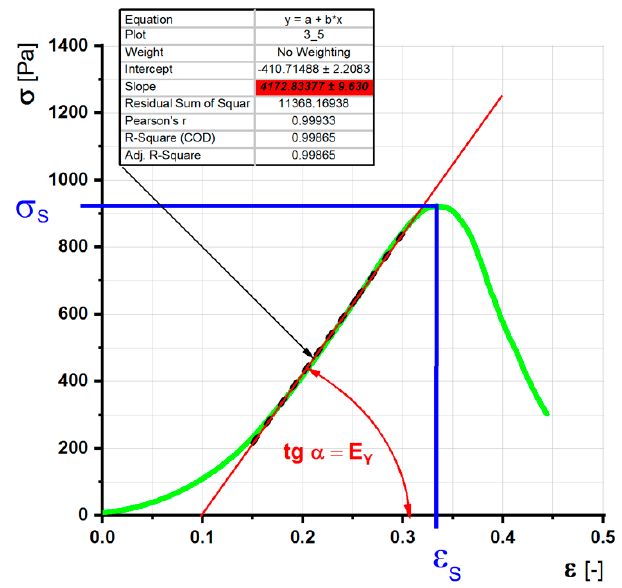
Figure 1. Determination of the limits of strength, elongation, and Young’s modulus of elasticity E Y using the linear regression of the stress versus relative shortening curve.